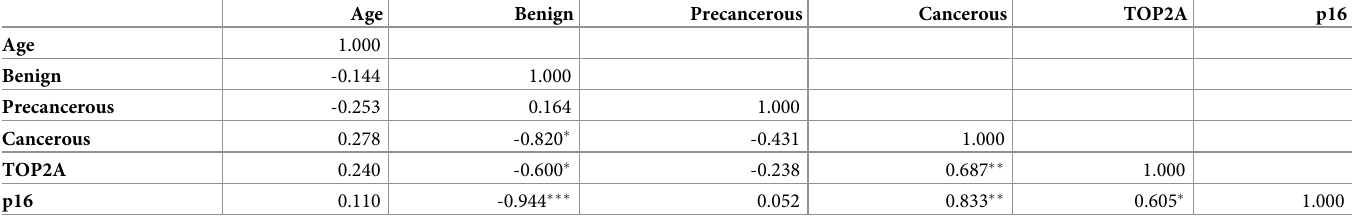
Table 3. Correlation matrix for p16 and TOP2A biomarkers expression with the histopathological factors among women seeking cervical cancer care at Kiliman- jaro Christian Medical Centre (n = 139). Age Benign Precancerous Cancerous TOP2A